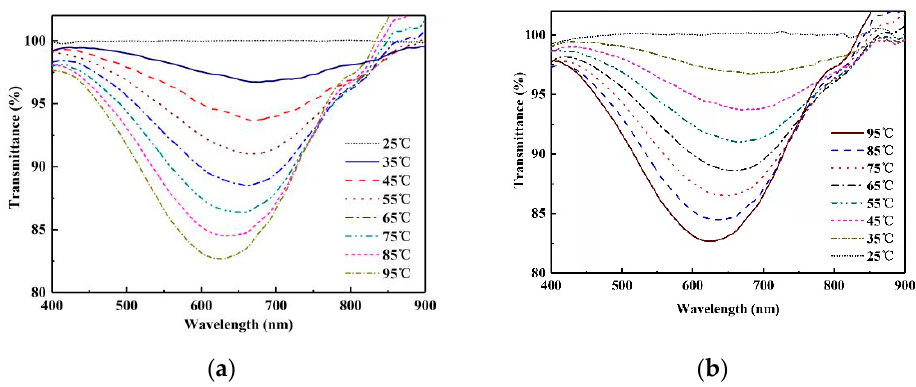
Figure 8. Normalized transmission spectrum of the MSF temperature sensor under: ( a ) the heating process; ( b ) the cooling process.